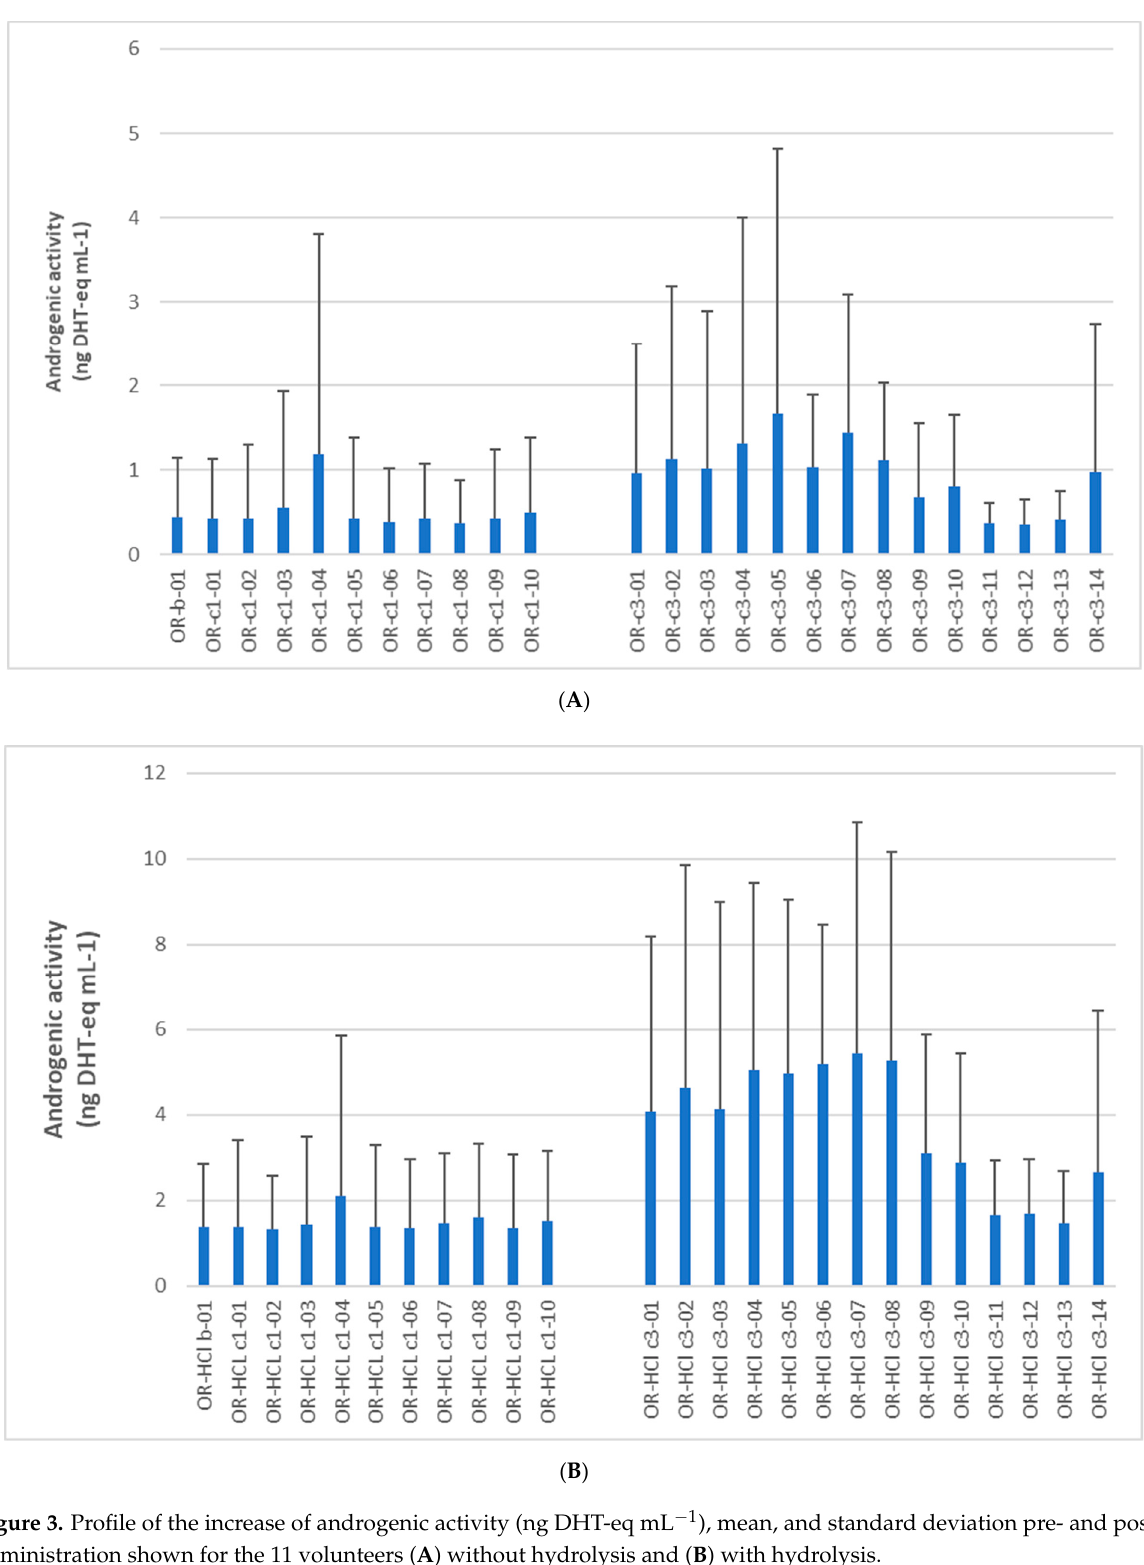
Figure 3. Profile of the increase of androgenic activity (ng DHT-eq mL − 1 ), mean, and standard deviation pre- and post-T administration shown for the 11 volunteers ( A ) without hydrolysis and ( B ) with hydrolysis.